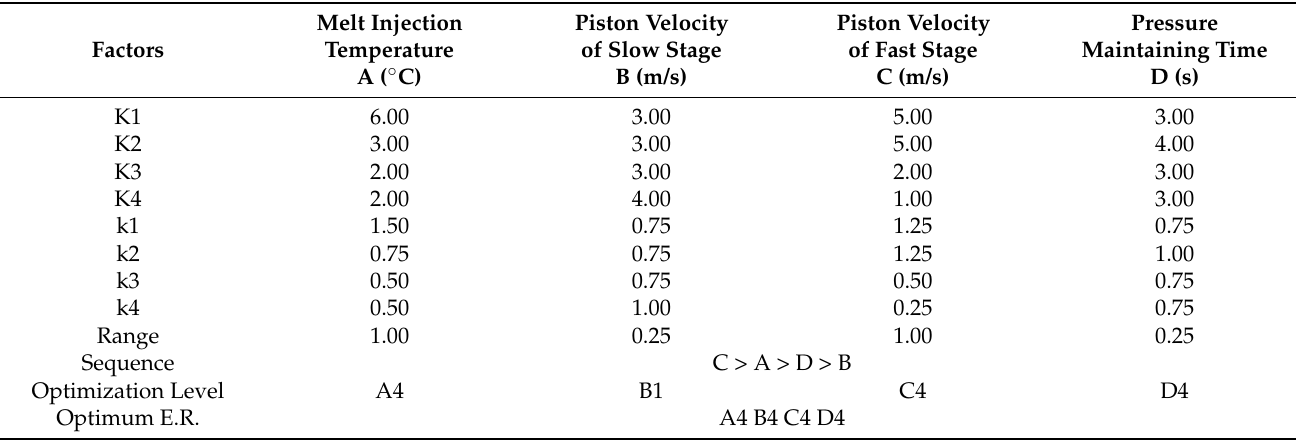
Table 7. Table of gas porosity by means of range